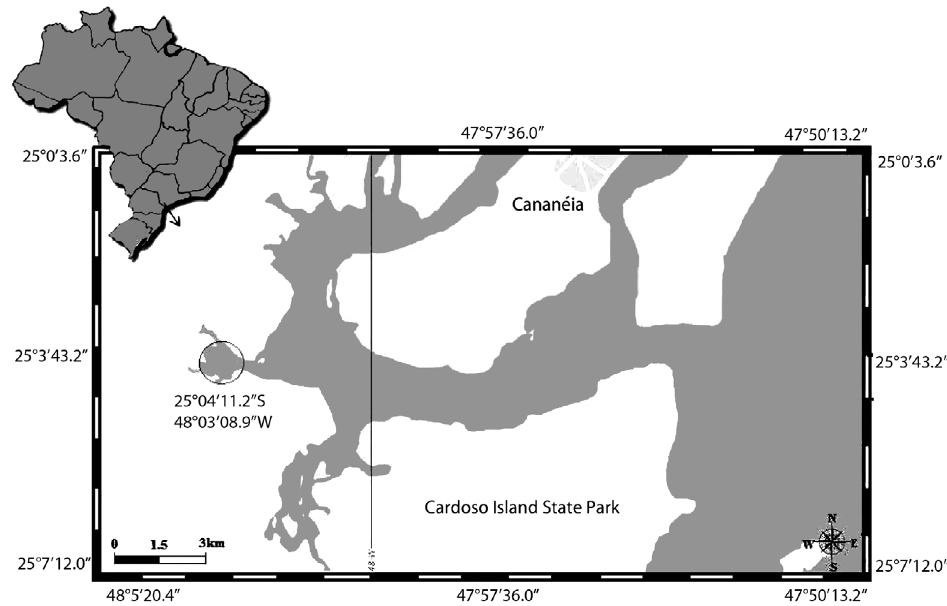
Figure 1. Location of the study area, water represented by dark grey in the map of the intertidal estuarine zone of Cananéia, São Paulo, south–eastern Brazil. Adapted from Pescinelli et al.